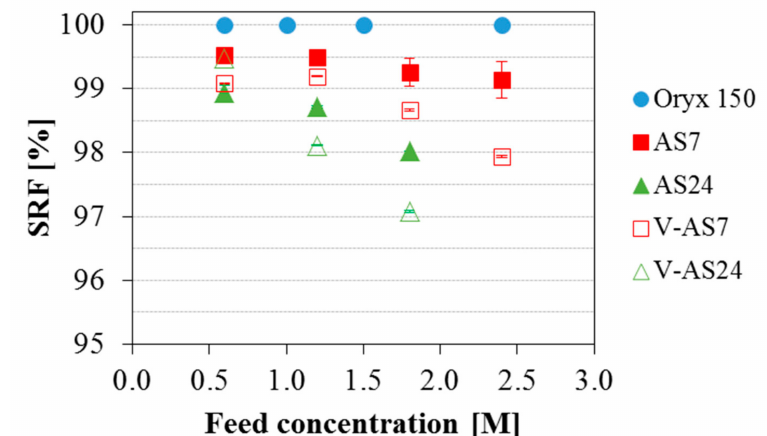
Figure 5. SRF obtained with the Oryx 150, the AS7 and the AS24 modules (in AGMD and V-AGMD configurations) for di ff erent initial feed concentrations. T hot = 80 ◦ C, T cold = 25 ◦ C and F = 1100 L · h − 1 (AS modules) and 600 L · h − 1 (Oryx 150).